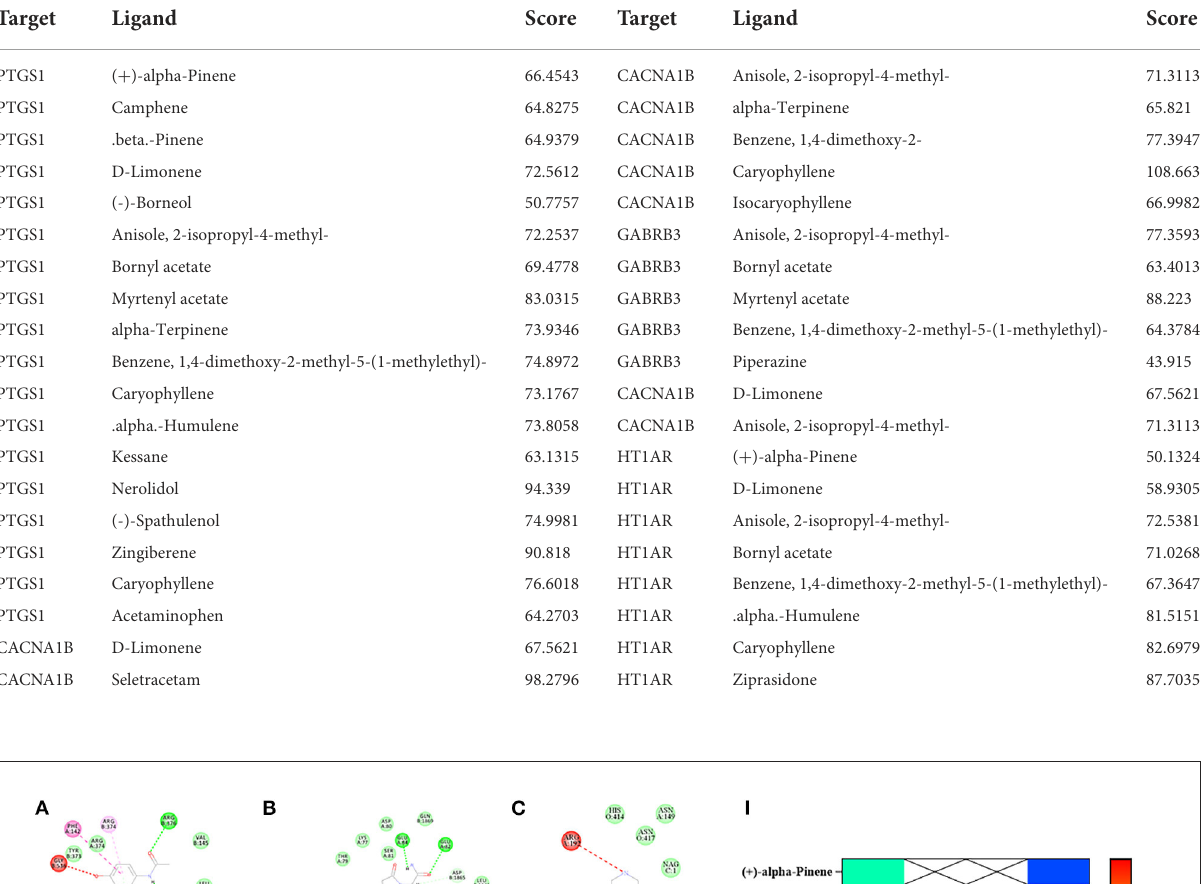
TABLE 3 Results of target ligand binding fraction.